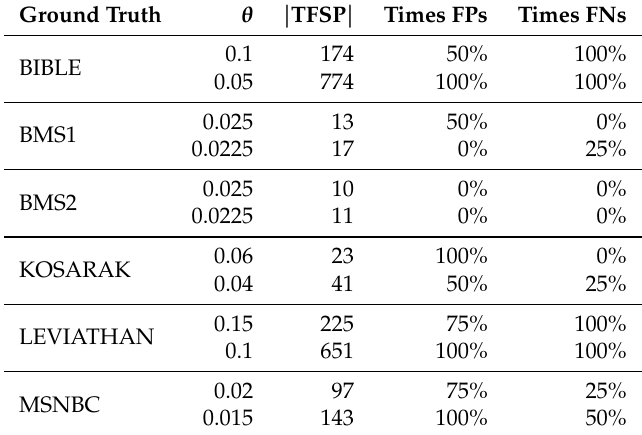
Table 3. Average fraction of times that FSP ( D i , θ ) , with D i a pseudo-artificial dataset, contains false positives, Times FPs, and misses true frequent sequential patterns (TFSPs) (false negatives), Times FNs, over 4 datasets D i from the same ground